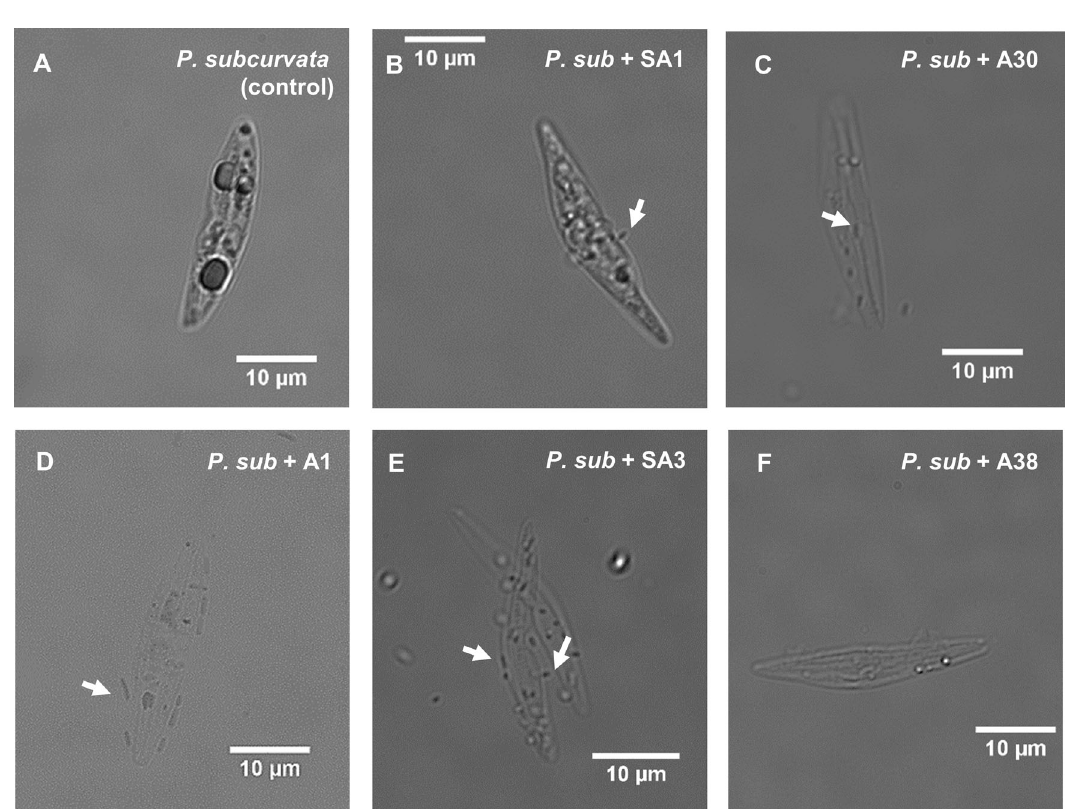
Fig. 5 Co-isolated bacterial strains physically associate with P. subcurvata in coculture. Single cell DIC microscopy images were taken with a Nikon Ti-2 inverted epi fl uorescence microscope using 100x objective and NIS Elements acquisition software. Images are from vitamin- limited cocultures at day 42. Images are representatives of P. subcurvata cells grown alone ( A ) or with indicated bacteria ( B – F ). Arrows indicate bacterial cells.